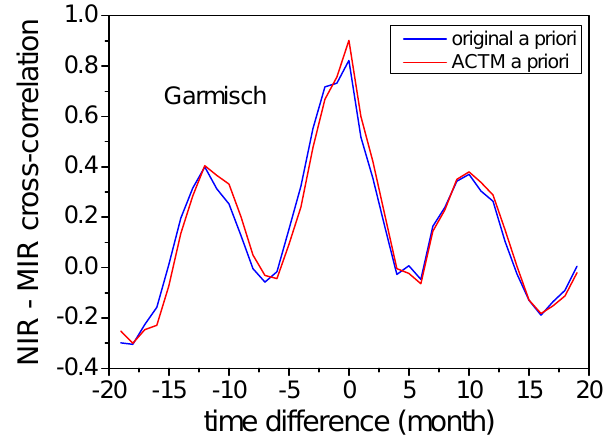
Fig. 6. Cross-correlation of Garmisch NIR and MIR monthly mean time series. Blue: retrievals with original a priori profiles. Red: re- trievals with ACTM profiles as common a priori.